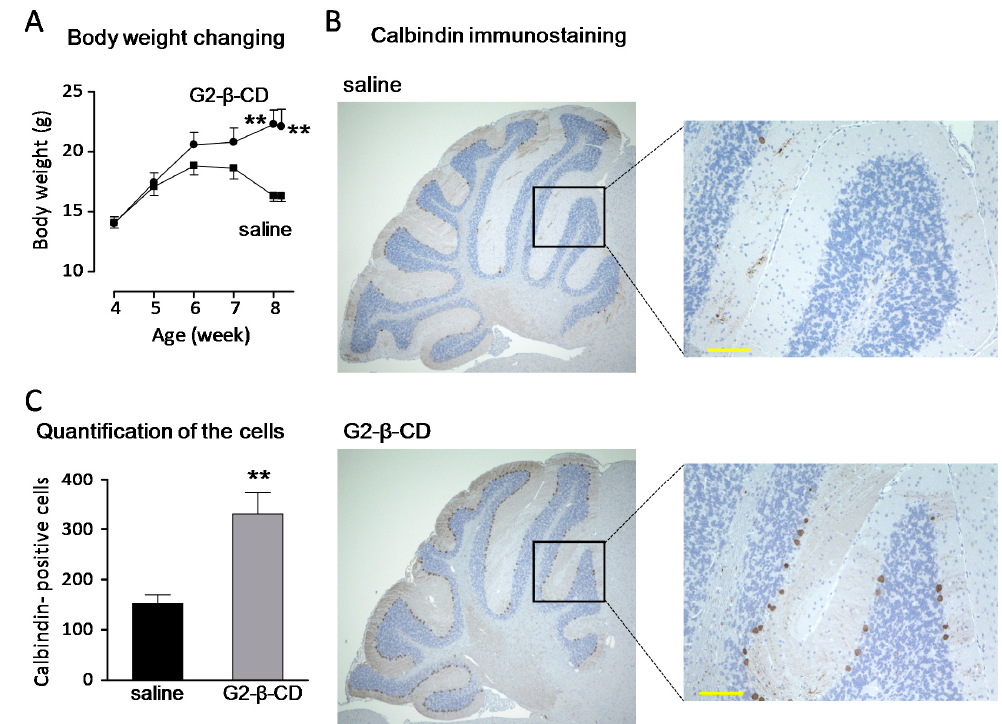
Figure 7. Preventive effects of an intracerebroventricular injection of G2- β -CD on body weight loss ( A ) and Purkinje cell loss in the cerebellum (B and C) of Npc1 − / − mice. An injection of G2- β -CD 21.4